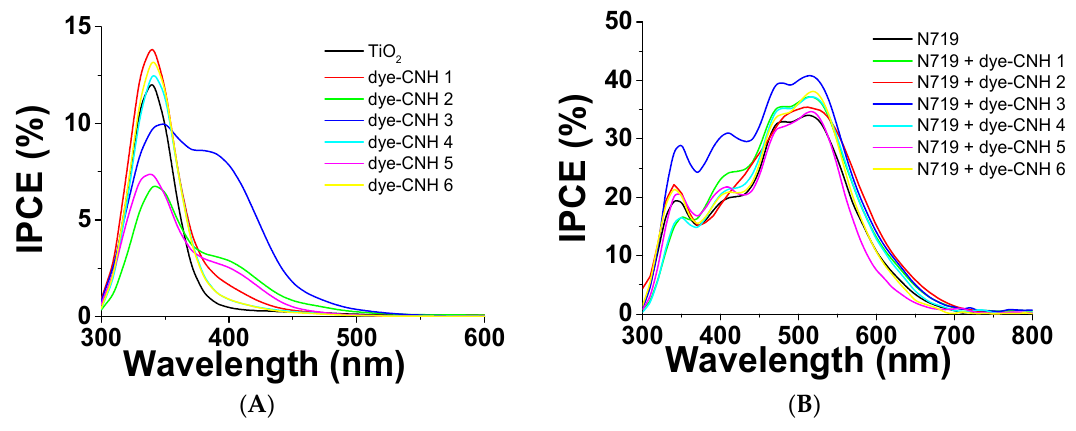
Figure 11. Photoresponse spectra plotted as incident photon-to-current efficiency (IPCE). ( A ) Without N719 dye sensitizer and after sensitization with N719 dye ( B ).